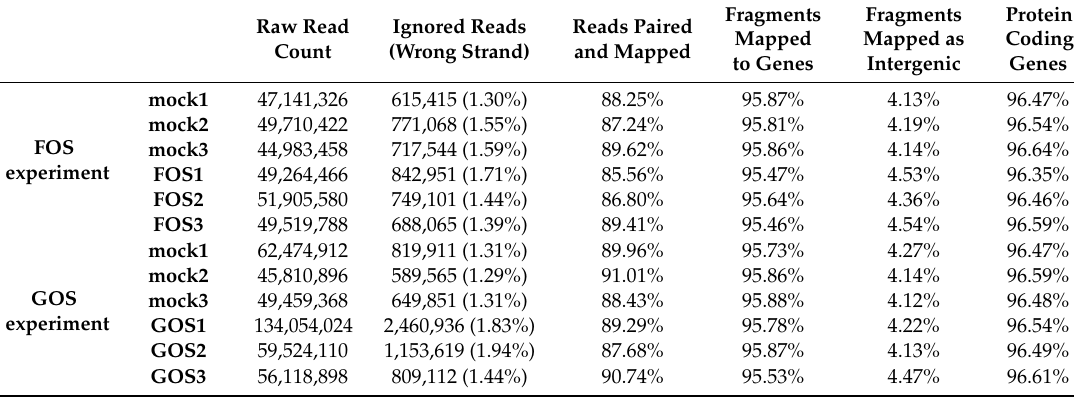
Table 4. Summary of sequencing reads mapped to the human reference genome. RNA sequencing was strand-specific and only reverse strand reads were mapped to the reference genome Homo sapiens Hg38. FOS (1–3) and GOS (1–3) are oligosaccharide-treated groups, the experiment specific control treatment groups are referred to as “mock” (1–3); each treatment consists of three independent biological replicates (labelled 1–3) that were created from a pool of three technical replicates ( n = 3). Raw Read Ignored Reads Reads Paired Count (Wrong Strand) and Mapped